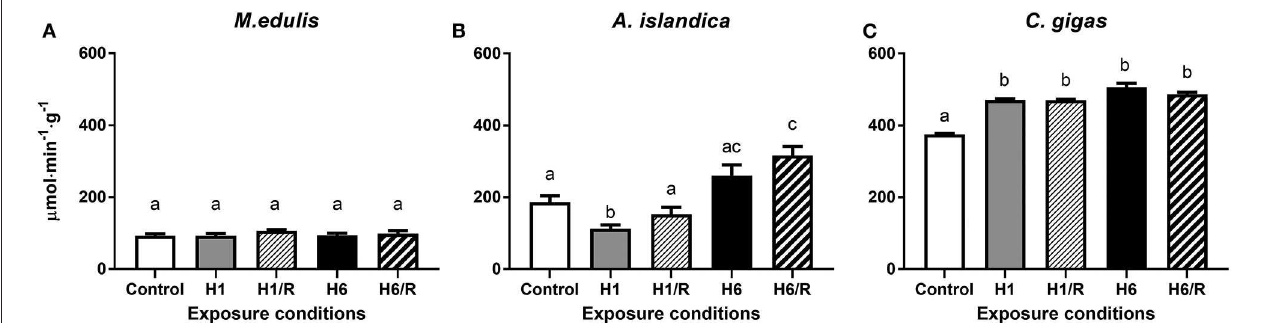
FIGURE 2 | Activities of protein phosphatases in the digestive gland of three species of marine bivalves during the exposure to H/R stress. (A) The mussels M. edulis , (B) the quahogs A. islandica , and (C) the oysters C. gigas . Exposure conditions are control (normoxia), 1 day hypoxia (H1), 1h reoxygenation following 1 day of hypoxia (H1/R), 6 days of hypoxia (H6), and 1h reoxygenation following 6 days of hypoxia (H6/R). Activities are expressed in µ mol product per minute per gram wet tissue mass. Columns that do not share a letter represent significantly different values ( p < 0.05). The vertical bars represent S.E.M. N =